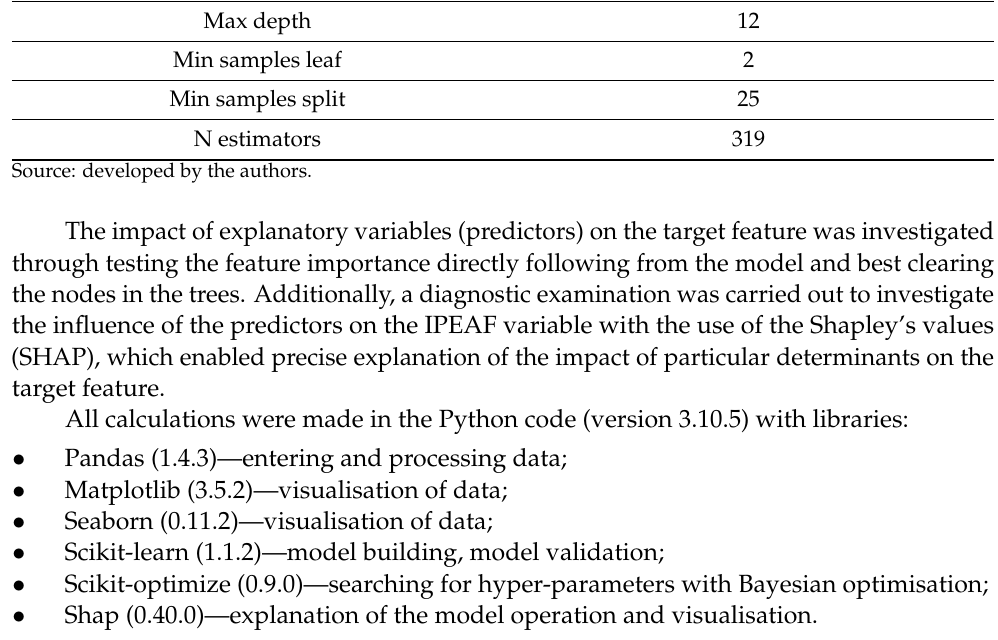
Table 3. Basic hyper-parameters of the construed Extra Trees model. Parameter Value Max depth 12 Min samples leaf 2 Min samples split 25 N estimators 319